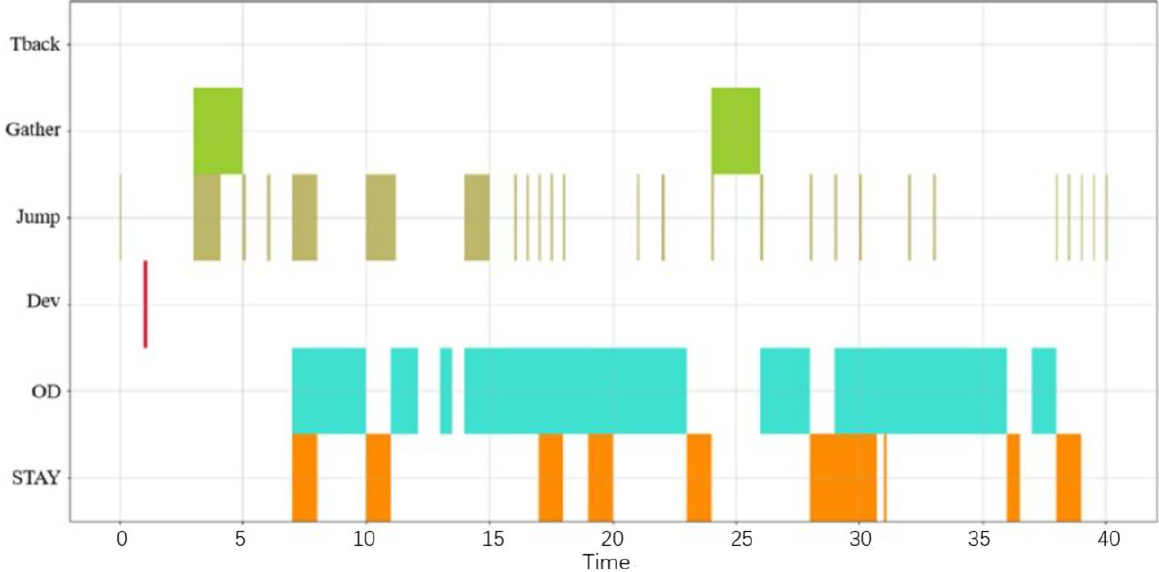
Figure 9. Cargo ship complex behavioral pattern